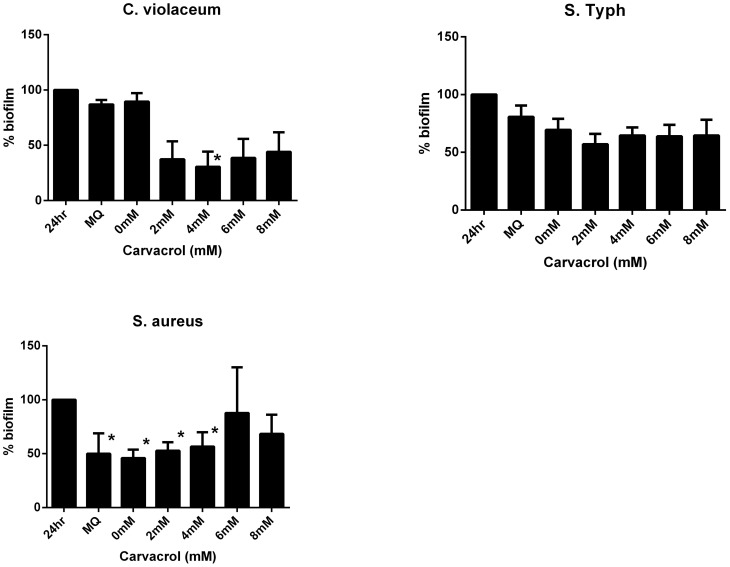
(A–C). Carvacrol has no significant effect on pre-formed biofilms.Percentage remaining of pre-formed biofilms after 24 h incubation in presence or absence of carvacrol (0–8 mM). Expressed as percentage original biofilm measured as OD at 590 nm. C. violaceum (A), S. Typhimurium (B), S. aureus (C). Data points marked with asterisks are just significantly lower than the 24 h control (p = 0.05). Bars indicate standard error of the mean.